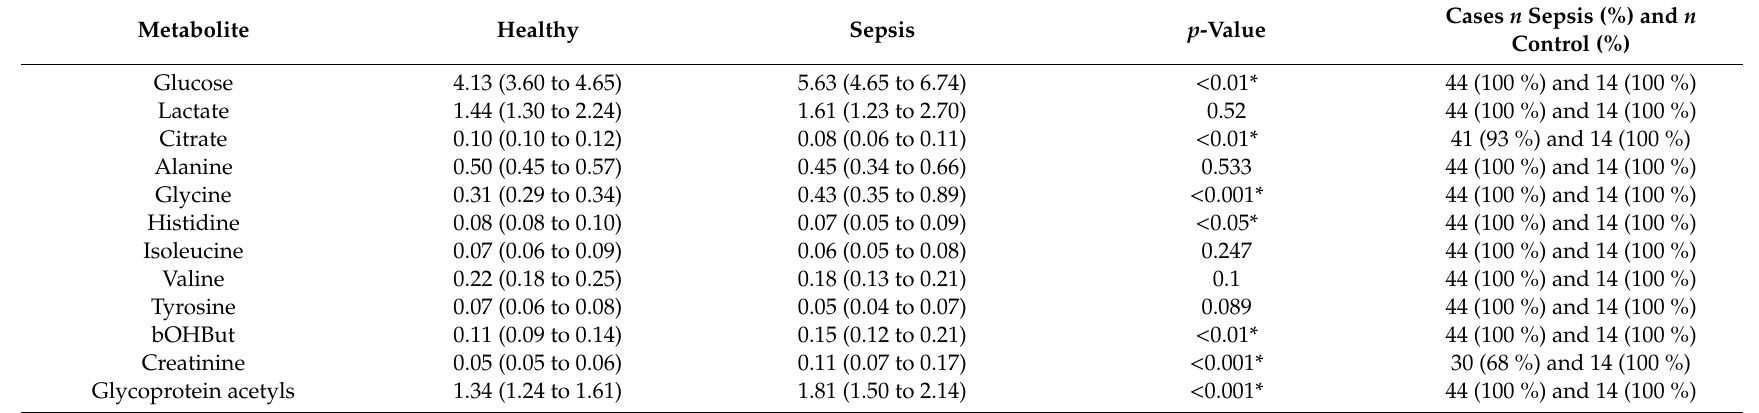
Table 2. Comparison of metabolite concentrations in sera between healthy controls and sepsis patients. Serum levels are presented as mmol / L. Median concentrations with 25th to 75th percentiles are shown. p < 0.05 is considered significant, and those values are marked with an *. bOHBut = 3-hydroxybutyrate.